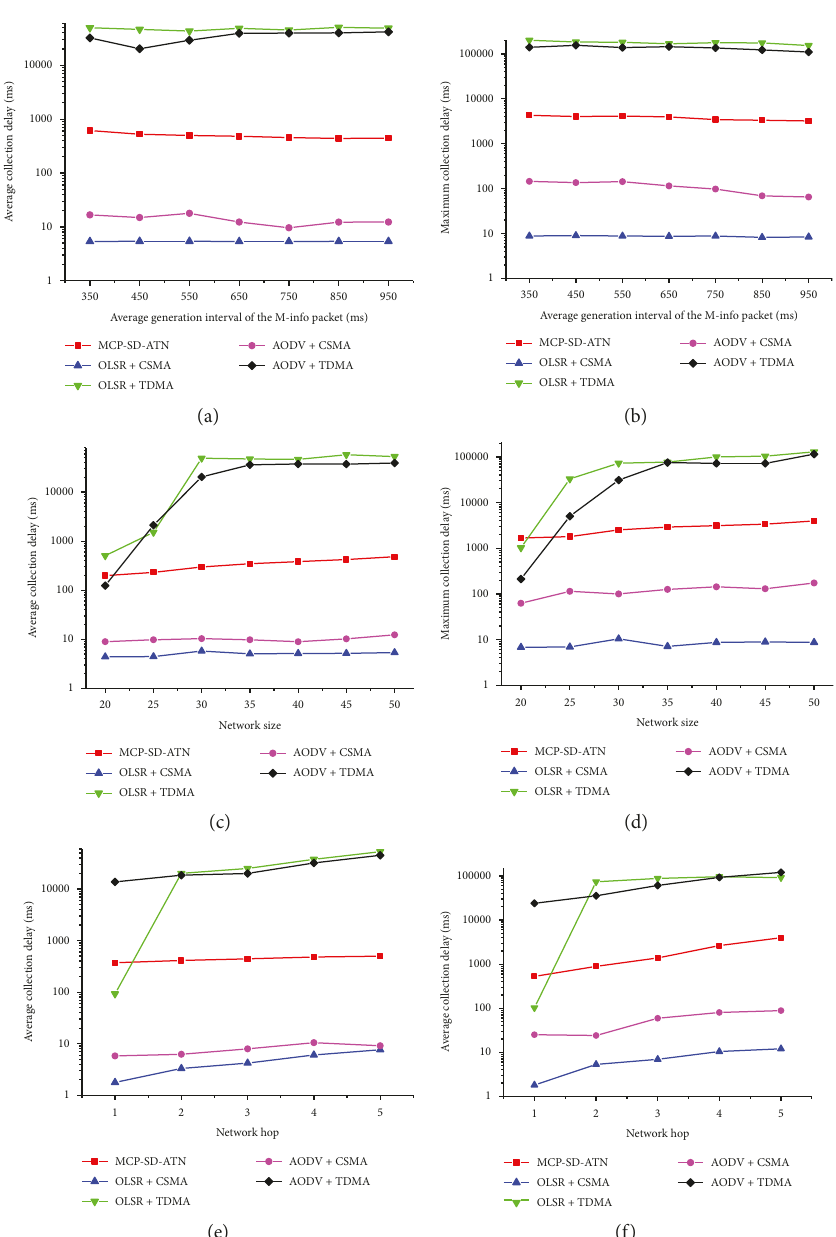
Figure 11: M-info collection delay. (a) Average collection delay with respect to the M-info tra ffi c. (b) Maximum collection delay with respect to the M-info tra ffi c. (c) Average collection delay with respect to the network size. (d) Maximum collection delay with respect to the network size. (e) Average collection delay with respect to the network hop count. (f) Maximum collection delay with respect to the network hop